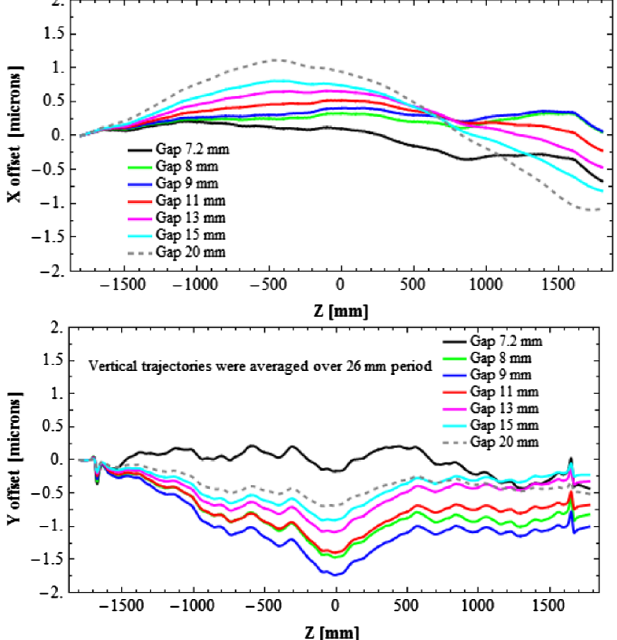
shims.FIG. 20. Horizontal (top) and vertical (bottom) trajectories calculated from the magnetic field profiles at several gaps after magnetic tuning. Electron energy is taken to be 14 GeV. The limits on the graph are the (cid:1) 2 μ m straightness